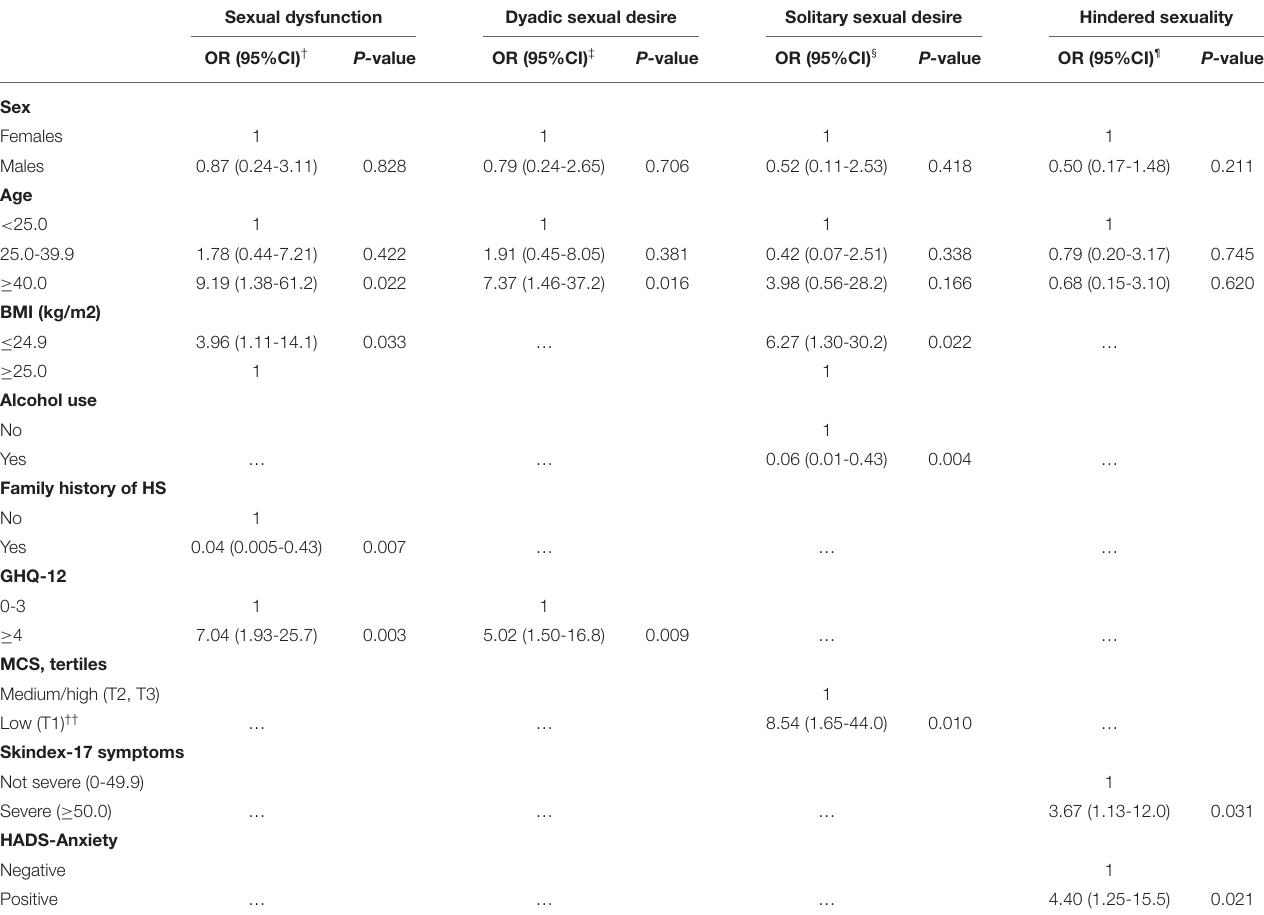
TABLE 3 | Multivariate analysis for factors associated with sexual dysfunction, dyadic sexual desire, solitary sexual desire, hindered sexuality (logistic regression models). Sexual dysfunction Dyadic sexual desire Solitary sexual desire Hindered